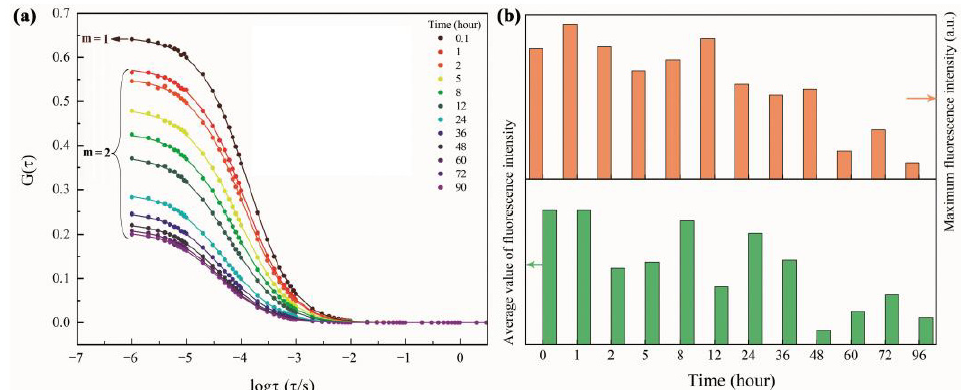
Figure 10. The ( a ) fluorescence correlation spectra and fluorescence fluctuation curves (inset) of RBA/ZEO in 3.5% NaCl + 500 µ mol Fe 3 + solution and ( b ) the statistical information of fluorescence fluctuation data.